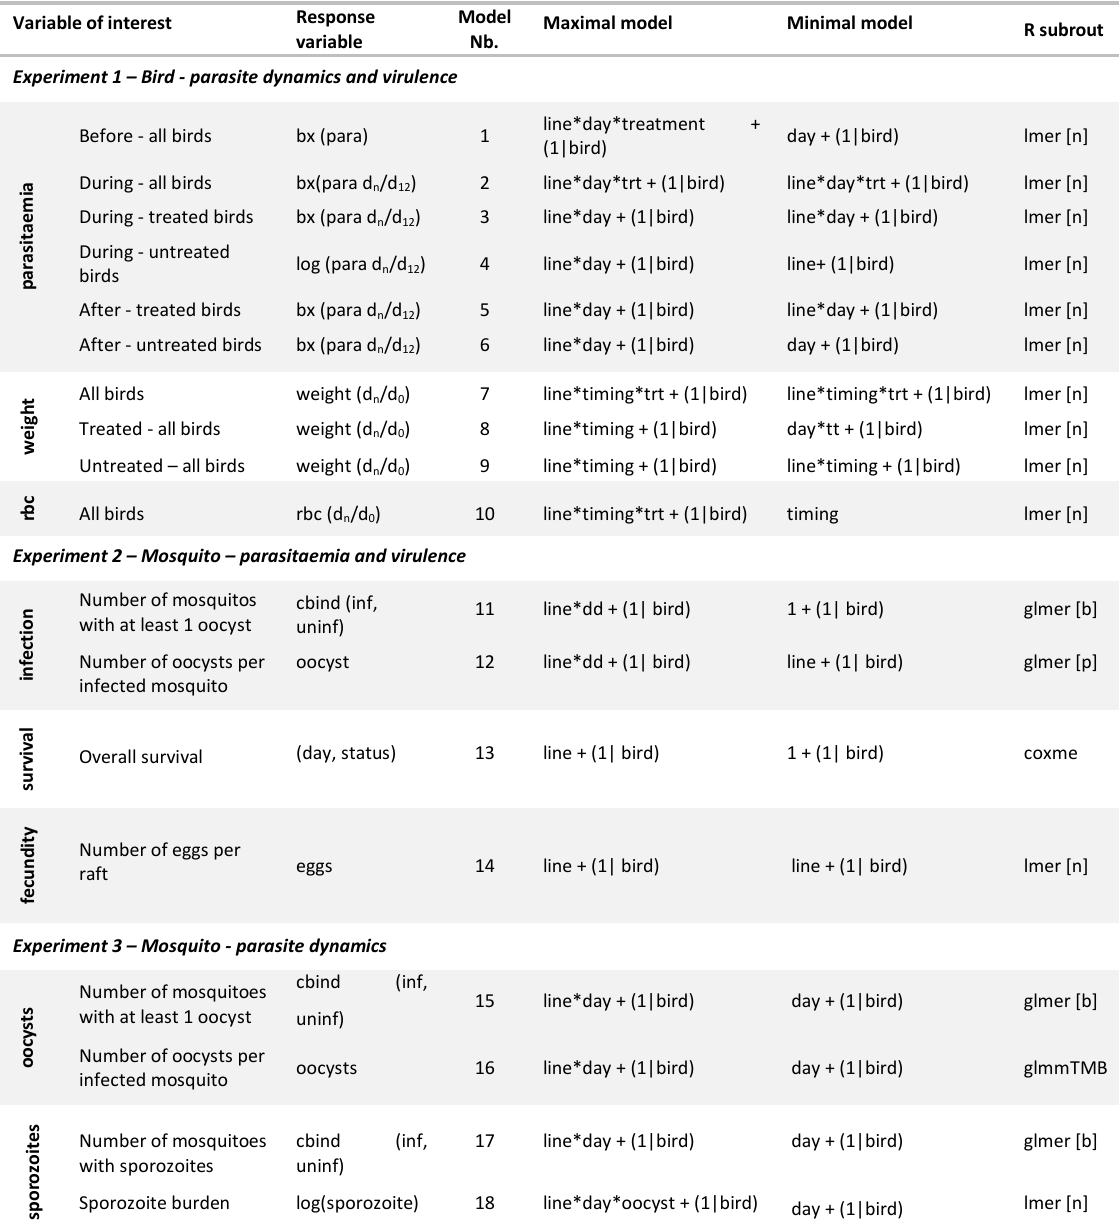
ST2: Description of the statistical models used to analyze the costs of AS-resistance in birds and vectors. N gives the number of mosquitoes or birds included in each analysis. "Maximal model" represents the complete set of explanatory variables (and their interactions) included in the model. "Minimal model" represents the model containing only the significant variables and their interactions. N denotes the total number of observations (nb: which is not always the same as the number of independent replicates). Round brackets indicate that the variable was fitted as a random factor. Square brackets indicate the error structure used (n: normal errors, b: binomial errors), day : sampling day, timing : whether it’s before, during or after the treatment, status : alive/dead on sampling day, eggs : number of eggs laid, trt : treatment (AS or sham- treated), line : parasite line, para : proportion of infected red blood cells, rbc : number of red blood cells per